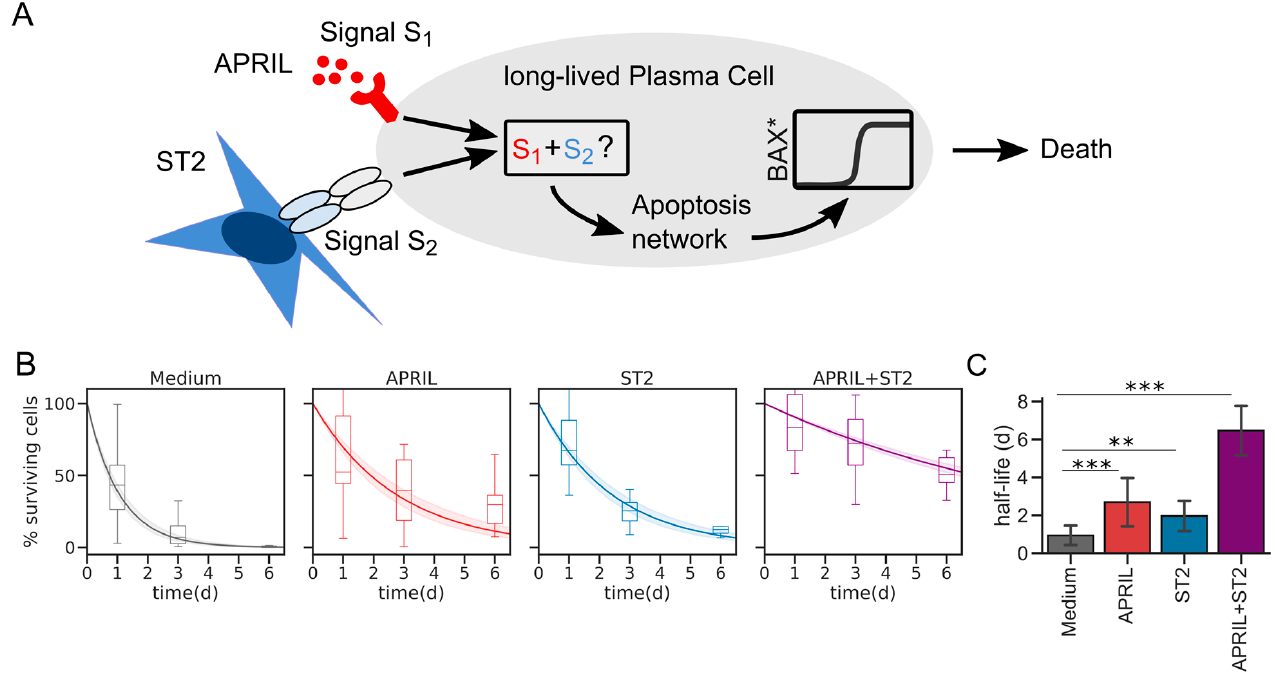
Figure 1. Regulation of plasma cell survival via APRIL and ST2. ( A ) Schematic signal integration of ST2 and APRIL. How the signals are integrated into the BAX-dependent apoptosis network is yet unclear. Time course data were taken from Ref. [12] and are here represented as Box plots. Data were fitted to exponential curves, each experiment at a time (Supplementary Figure S1). Curves shown here represent mean + s.e.m. of those fit results. BAX* denotes activated BAX. ( C ) Average half-lives of each condition based on the fitting procedure from ( B ). ** p < 0.01, *** p < 0.001, n > 12 fits per condition. Error bars represent standard